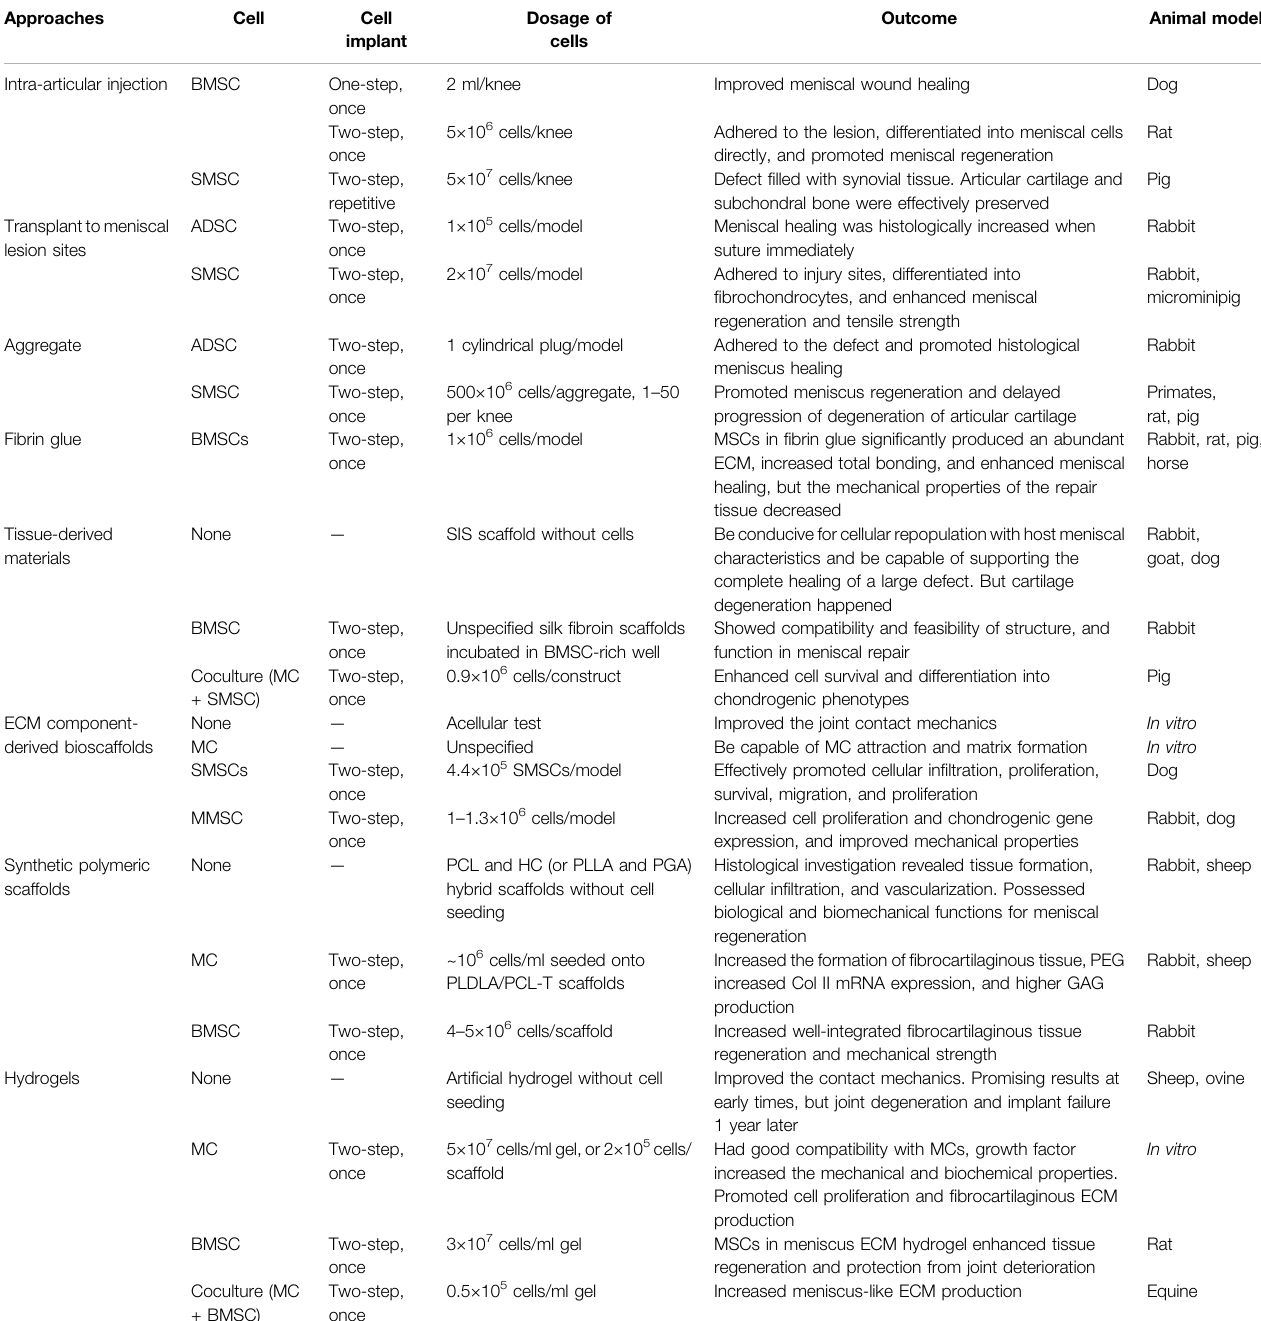
TABLE 1 | Classi fi cation based on approaches of MSC therapies. Approaches